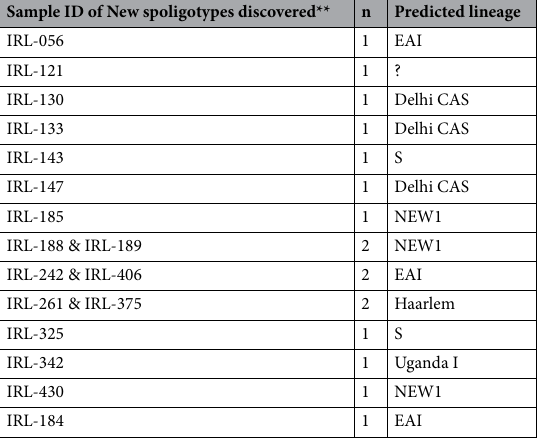
Sample ID of New spoligotypes